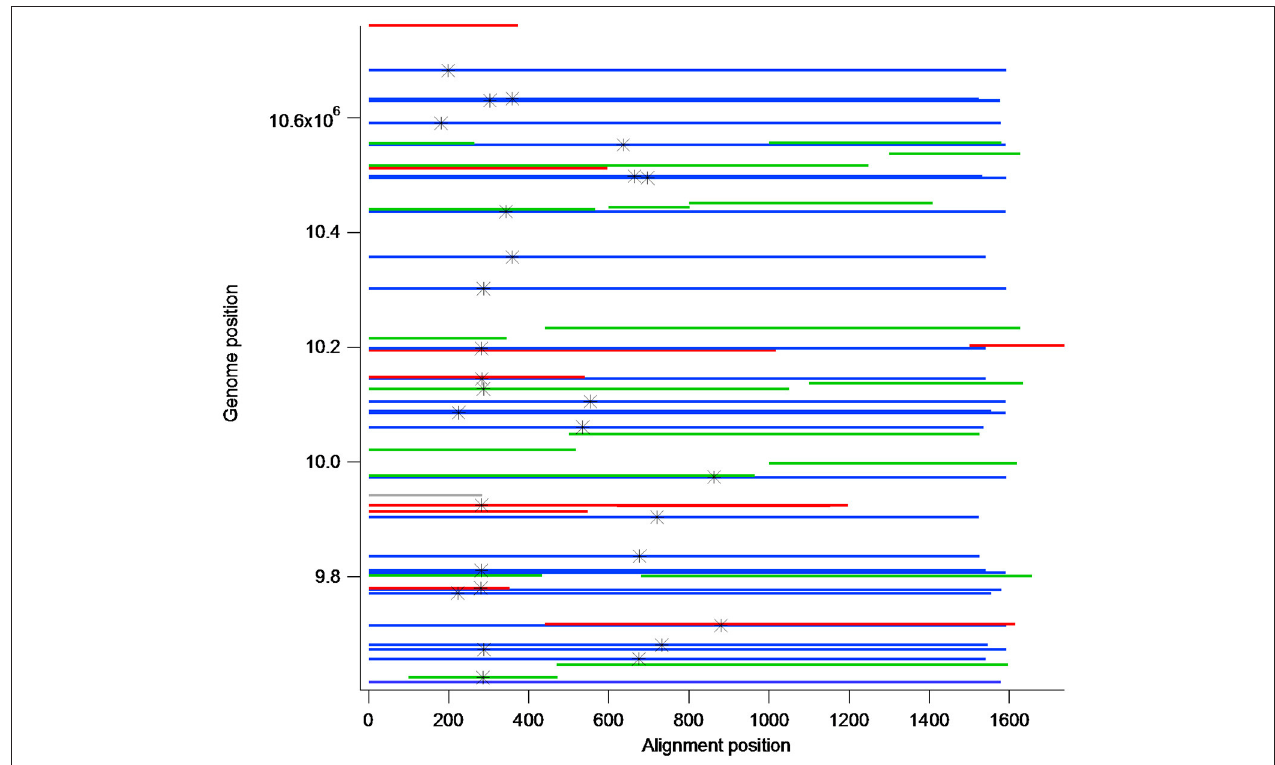
FIGURE 4 | Alignment of 58 W22 PME-like sequences and their relative chromosome 4 genomic positions. Blue bars are full length PME-like sequences, green and red bars are middle and short length sequences, respectively. The positions of the first in-frame stop codon are indicated by an